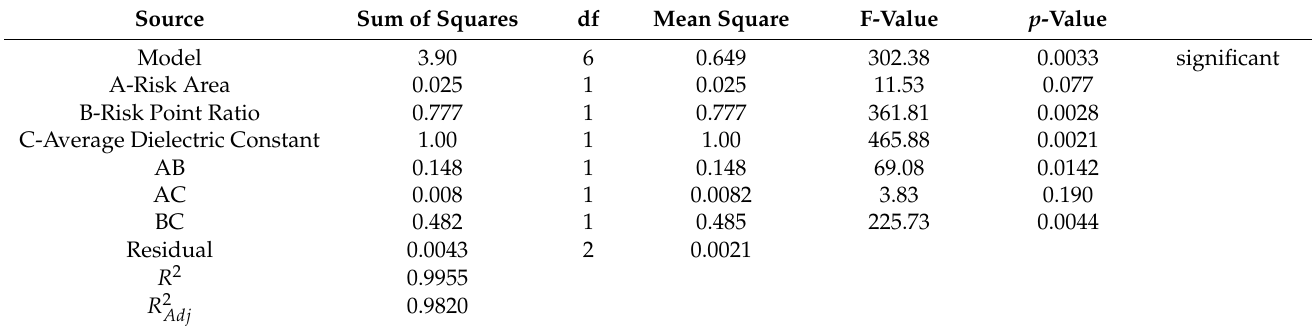
Table 2. The variance analysis of the mean void content of regional core